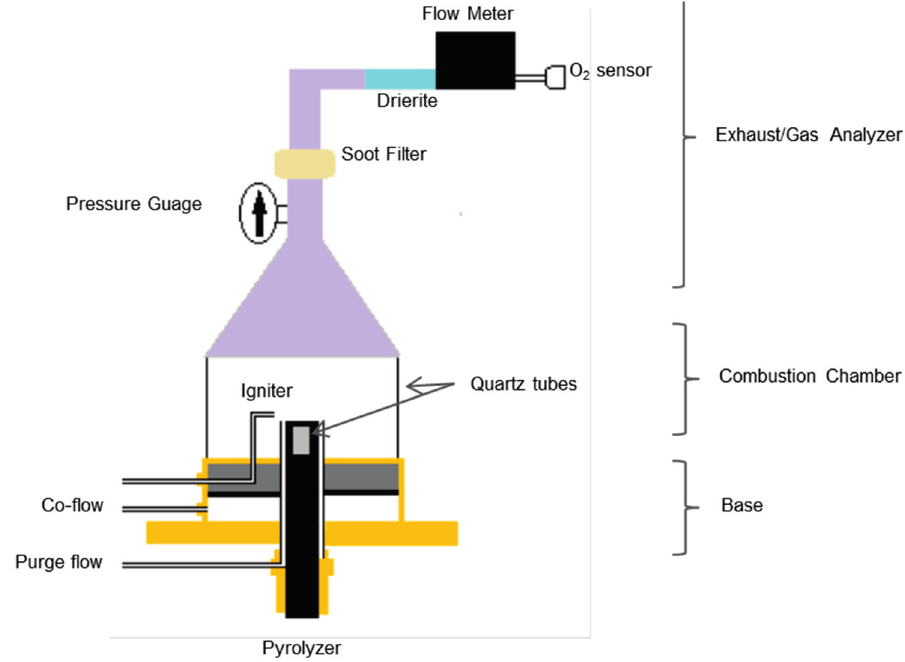
Figure 1. General scheme of MFC (Milligram-scale Flame Calorimeter) or FCC (Flaming Combustion Calorimeter)